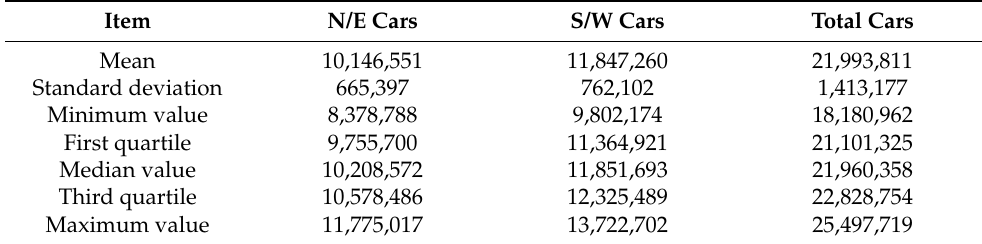
Table 2. Descriptive statistics for monthly traffic count